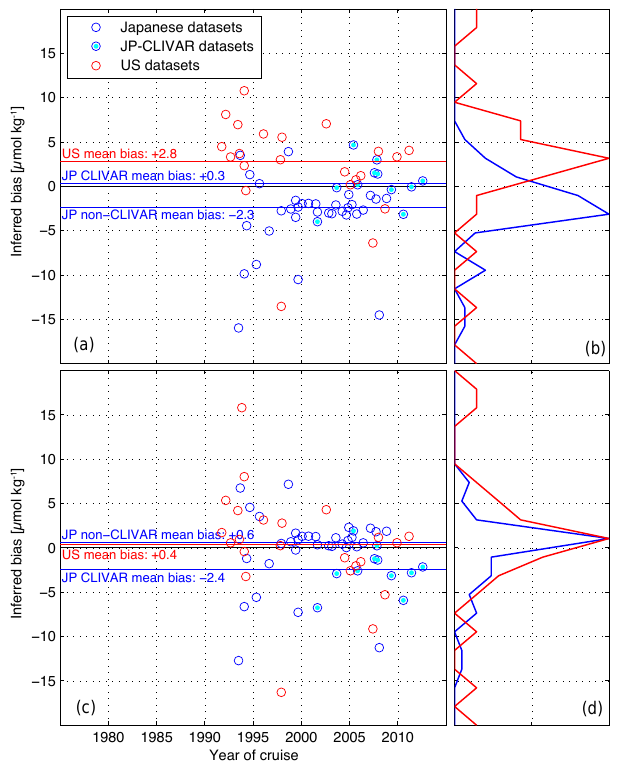
Figure 5. TAlk biases between US and Japanese efforts before (a, b) and after (c, d) pre-adjustments were applied to TAlk data of Japanese non-CLIVAR cruises (see main text for details). Cir- cles represent the biases (inferred by the GLODAPv2 inversion method) of TAlk measurements of individual cruises in the Pacific Ocean. Data of “Line P” and many small-scale cruises in the vari- able Kuroshio region were excluded from this analysis. Red and blue horizontal lines indicate countries’ approximate mean offset. For Japanese data the values are split into cruises that were or were not part of